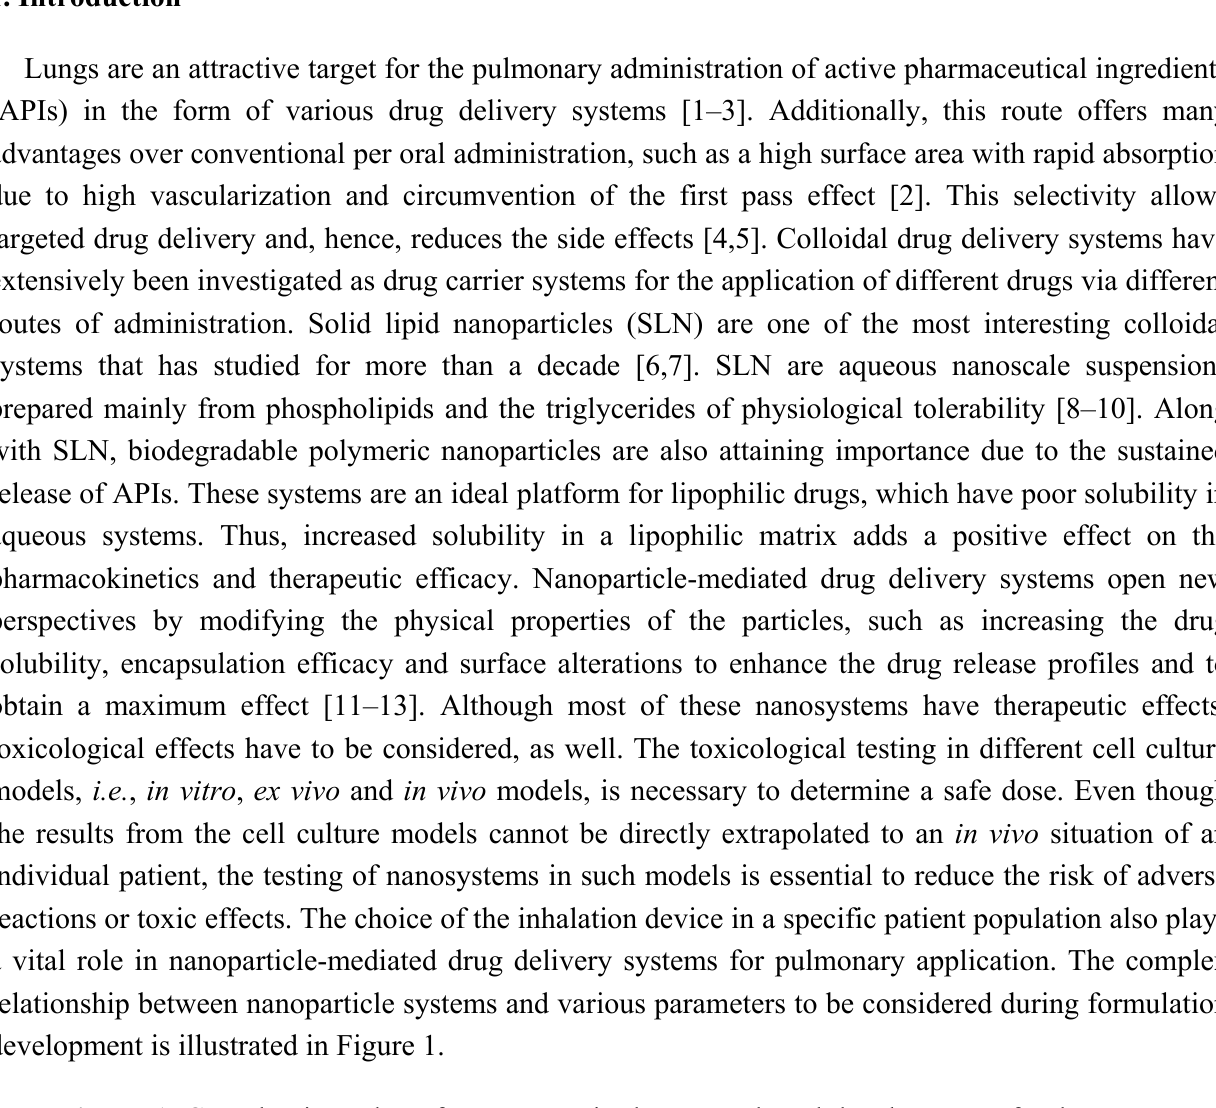
Figure 1. Complex interplay of parameters in the research and development of pulmonary drug delivery